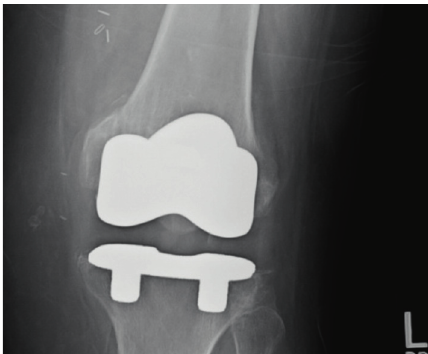
Figure 2: Anterior-posterior view of the left knee showing prior total knee